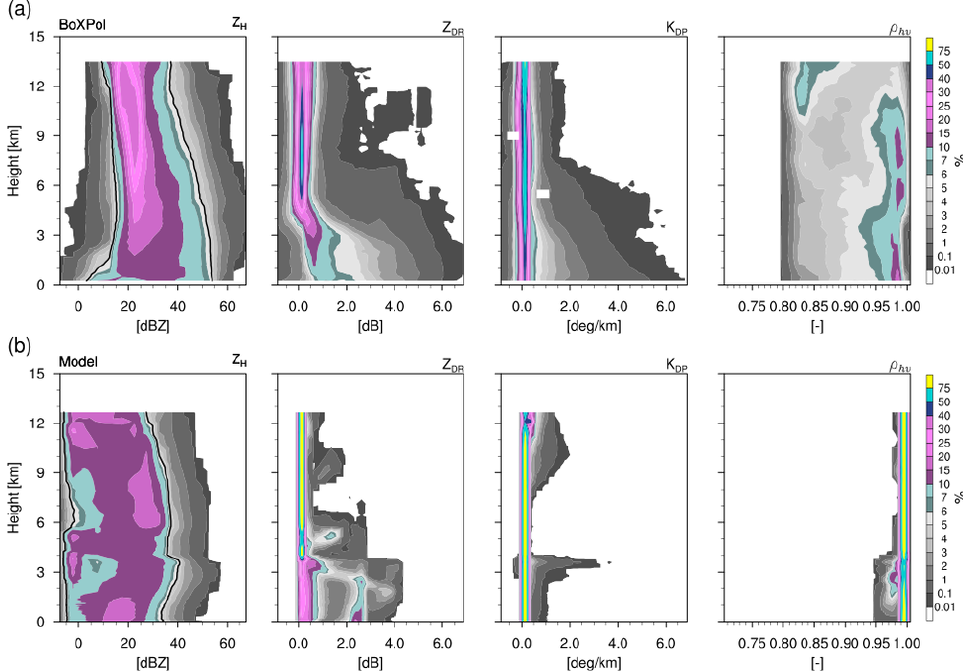
Figure 11. CFADs of horizontal reflectivity, differential reflectivity, specific differential phase and cross-correlation coefficient from 14:45 to 15:30UTC on 5 July 2015. CFADs from the model are shown for five ensemble members.